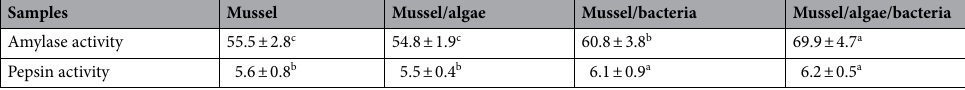
Table 4. Intestinal digestive enzyme activities of the mussel in different system. (U/mg prot). The different superscript letters indicated significant differences of the same enzyme activity among the different systems (P <